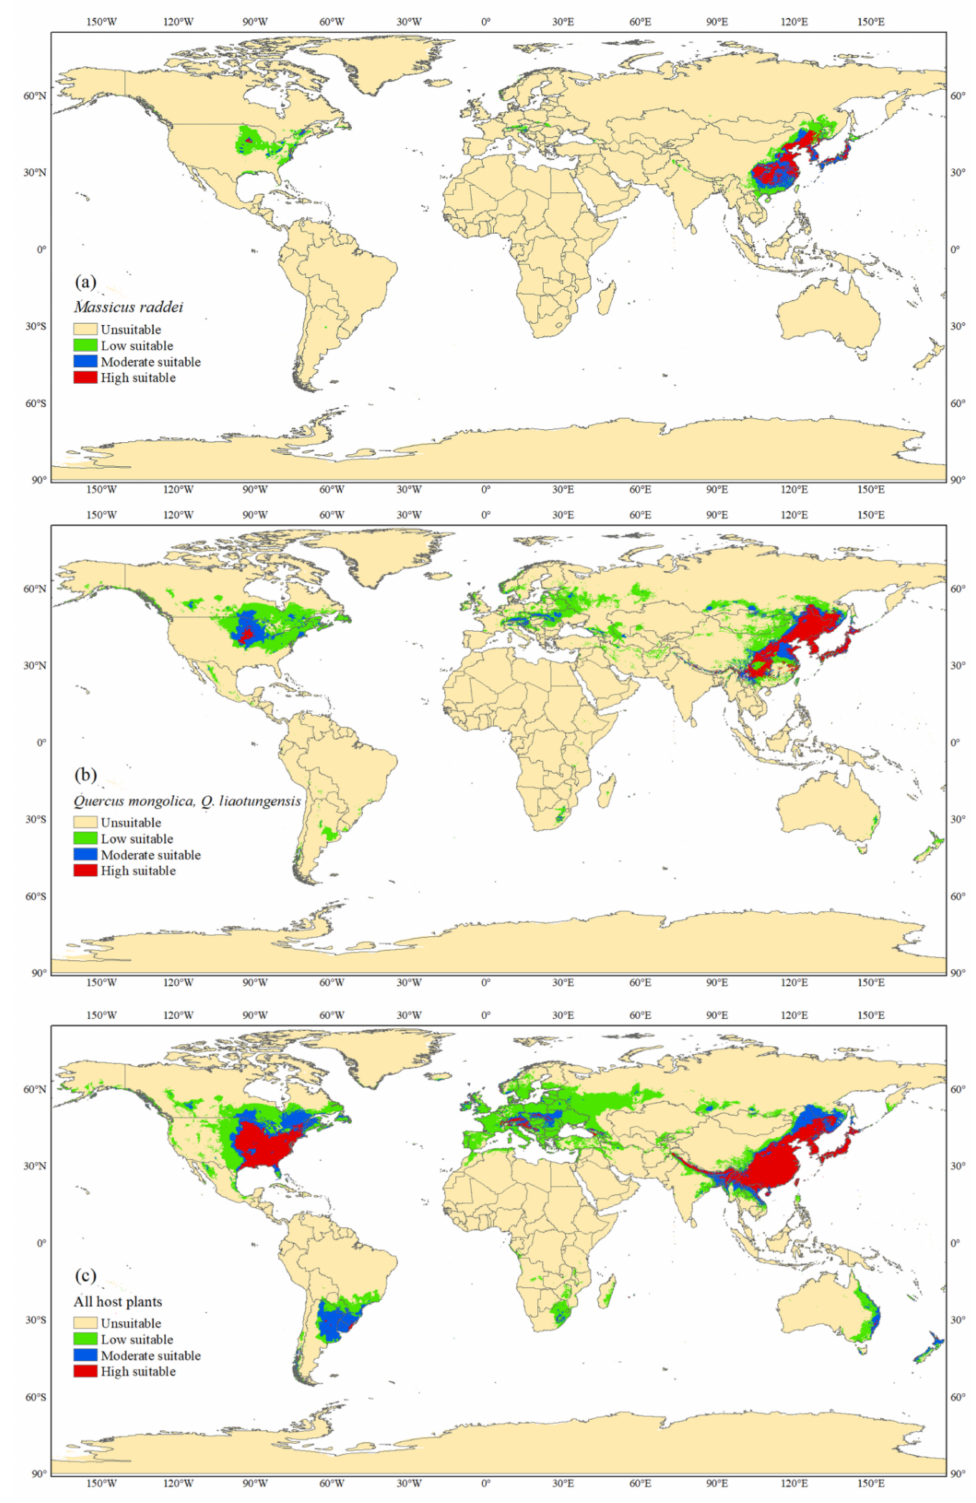
Figure 4. Predicted worldwide suitable habitat for M. raddei ( a ), susceptible hosts Q. mongolica and Q. liaotungensis ( b ) and all hosts by the MaxEnt model ( c